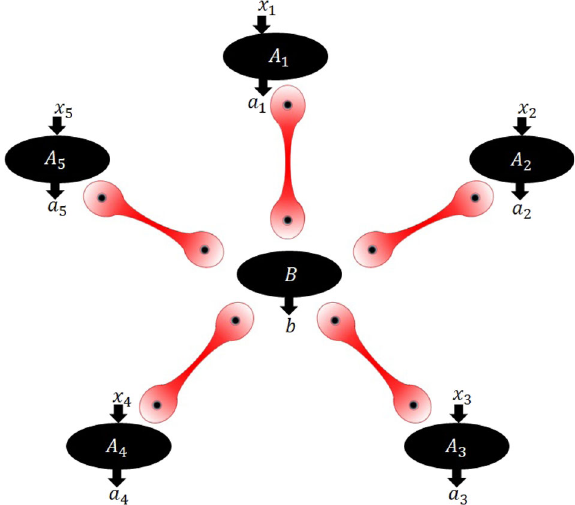
Fig. 2 Star network. A central node independently shares fi ve pairs of entangled qubits with separate nodes. By performing a BSM on fi ve qubits, the central node renders the fi ve initially independent nodes in a globally entangled state. With suitable local measure- ments, the correlations in the network become